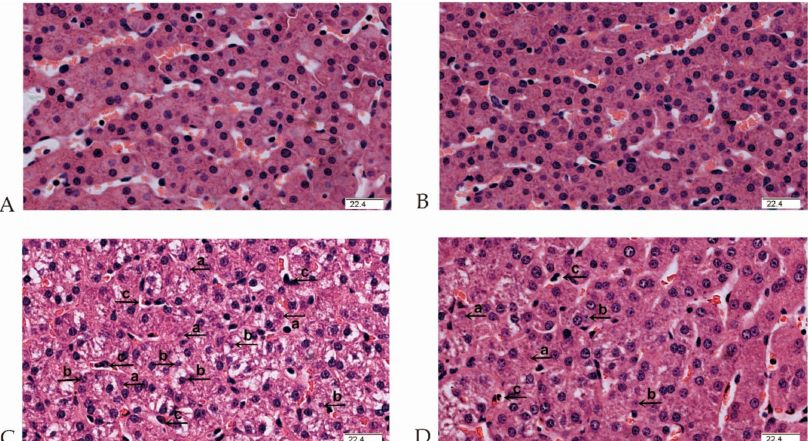
Figure 1. Effect of medium-chain triglyceride (MCT) supplementation on liver morphology after 4-h LPS challenge in weanling pigs. Pigs were subjected to a 2 × 2 factorial study fed with or without 4% MCTs for 21 days, followed by an intraperitoneal injection of saline or LPS on day 22. The representative liver histological sections from the four treatment groups were collected at 4 h after LPS challenge and stained with hematoxylin and eosin: ( A ) control diet and saline group, ( B ) 4% MCT diet and saline group, ( C ) control diet and LPS-challenged group and ( D ) 4% MCT diet and LPS-challenged group. While significant morphologic changes associated with liver injury, such as hepatocyte karyolysis (a), karyopyknosis (b), inflammatory cell infiltration (c) and disordered hepatic cell cords arrangement were observed in Panels C and D , significant attenuation of liver injury was observed in Panel D . Original magnification: 400 × . Scale bars = 22.4 µ